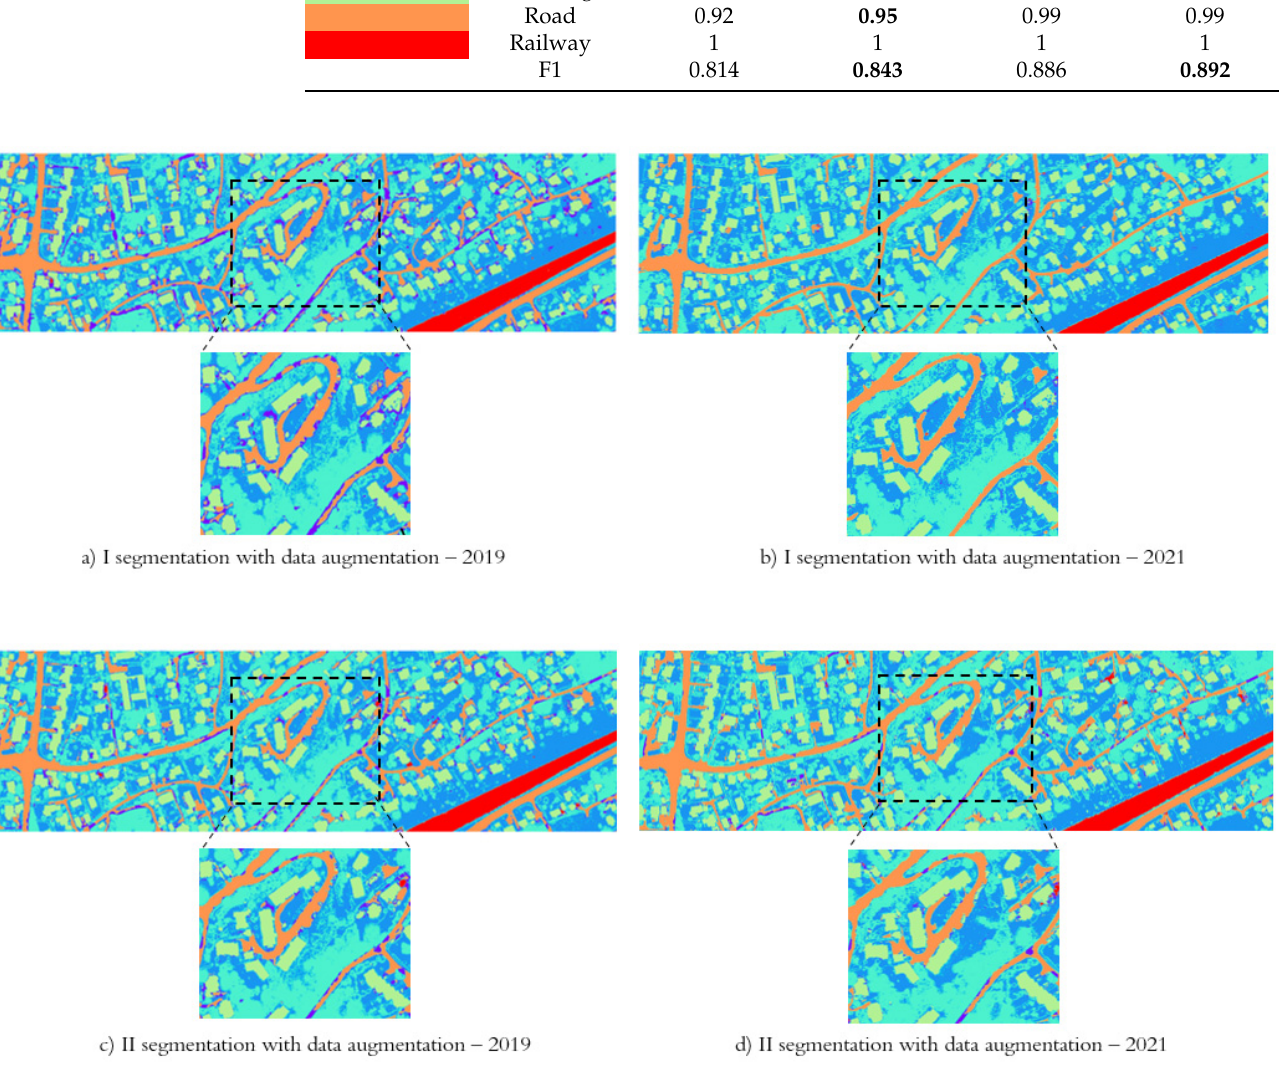
Figure 8. Segmentation results with data augmentation for the dataset from 2019 and 2021 for the ResU-Net showing ( a ) the first segmentation iteration for the dataset from 2019, ( b ) the first segmentation iteration for the dataset from 2021, ( c ) the second segmentation iteration for the dataset from 2019, and ( d ) the second segmentation iteration for the dataset from 2021.